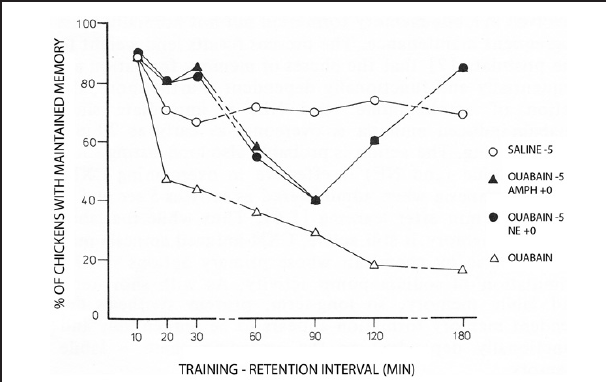
FIGURE 2 | Day-old chicks were during training exposed to a red bead tainted with the aversively tasting drug anthranilate and to an untainted blue bead. The Figure shows the percentage of trained chickens, which have learned to avoid the red color, which at the memory test was untainted. Under control conditions ∼ 70% remember. This number was rapidly reduced by administration of ouabain 5min before training (with saline added to the controls at the same time) to reach < 20% after 2–3h. However, the amnesic effect of ouabain was initially, and after a transient dip in memory, also at later times prevented by noradrenaline (NE) given at the time of learning (summarized on the Figure as ‘ouabain − 5, NE + 0). Amphetamine administered using the same time schedule, had a similar effect, probably due to noradrenaline release. Each point represents the average of measurements in 18–20 birds. For further details, see Gibbs and Ng (1977), from where the Figure is reproduced, with permission. For later procedural improvements see, e.g., Gibbs et al.